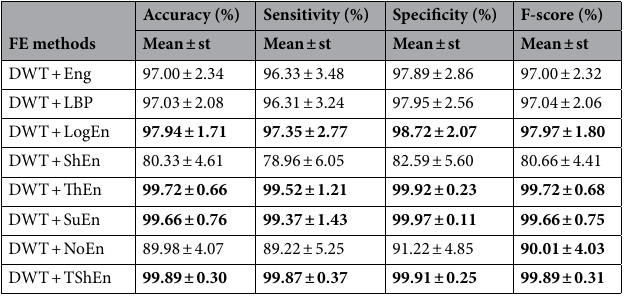
Table 5. Classification results of off-PD versus HC using KNN classifier (with DWT dec/recon). Significant values are in [bold].